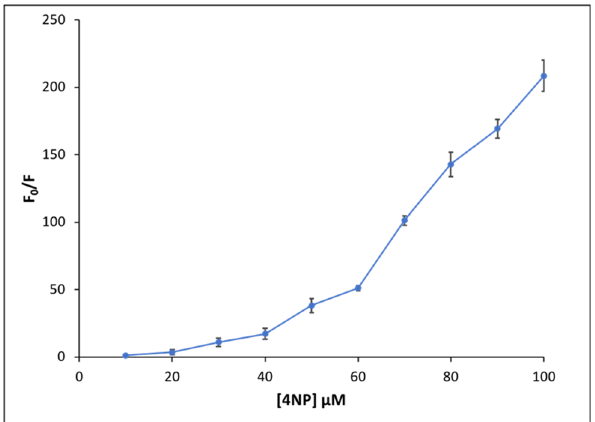
Figure 6. Stern–Volmer plot for fluorescence emission quenching of NaFl at different 4NP concen- trations.